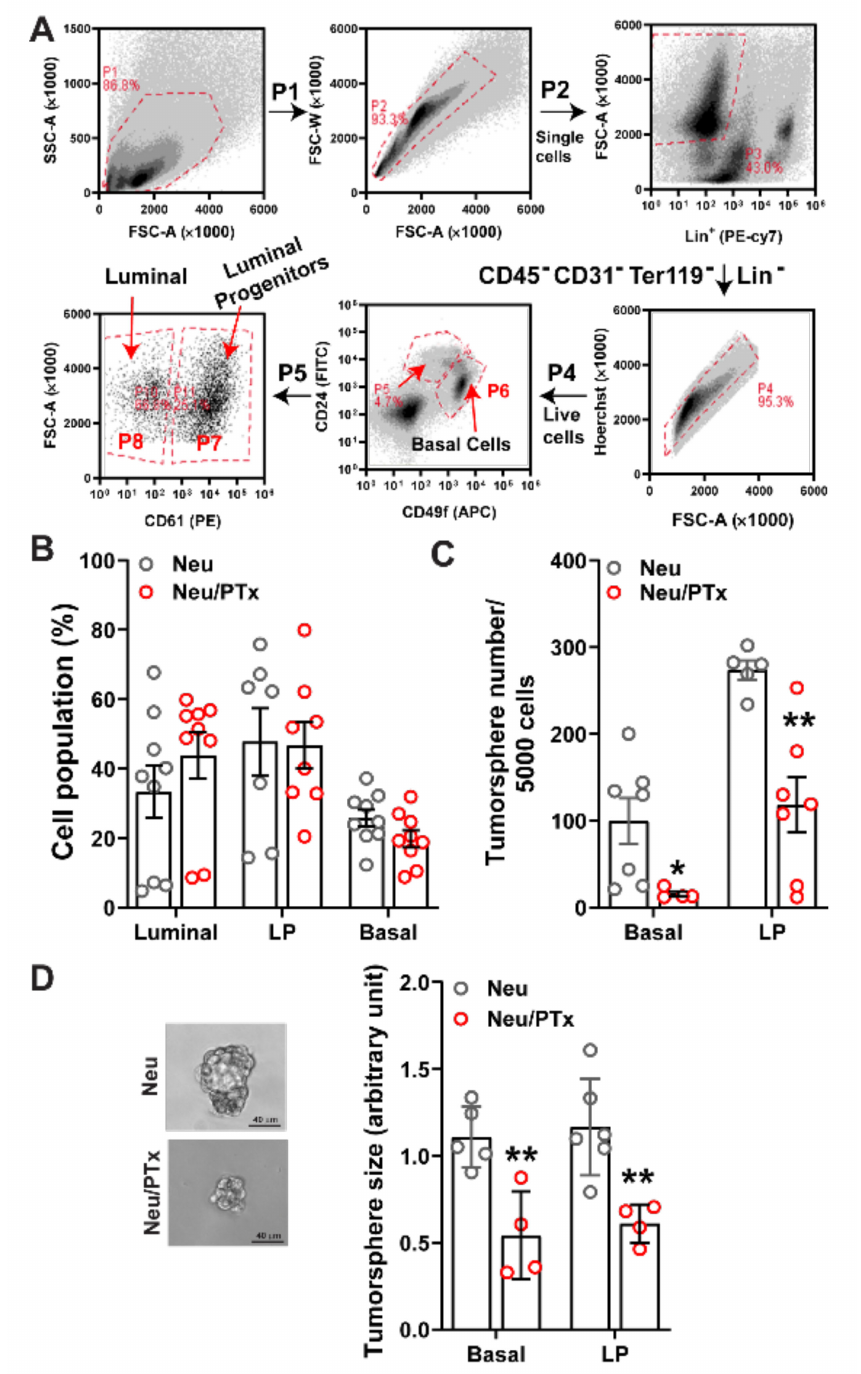
Figure 1. Blocking Gi/o-GPCR signaling in Neu-induced breast CSCs inhibits tumorsphere out- growth. ( A ) Schematic representation of isolating (via flow cytometry) luminal, luminal progenitors (LPs), and basal cells (basal) from premalignant mammary glands of mice. ( B – D ) The effect of PTx expression on luminal, LP, and basal populations ( B ) in Neu transgenic mice, and the size ( C ) and number ( D ) of tumorspheres formed from basal and LP cells in vitro. Representative images of tumorspheres from the basal cells of Neu and Nue/PTx mice are shown on the left panel of ( D ). *, ** p < 0.05 and 0.01 vs. Neu, respectively, n =